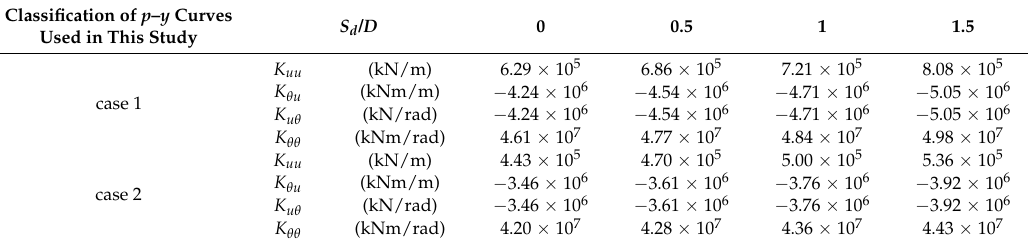
Table 5. Initial foundation stiffness of case 1 and case